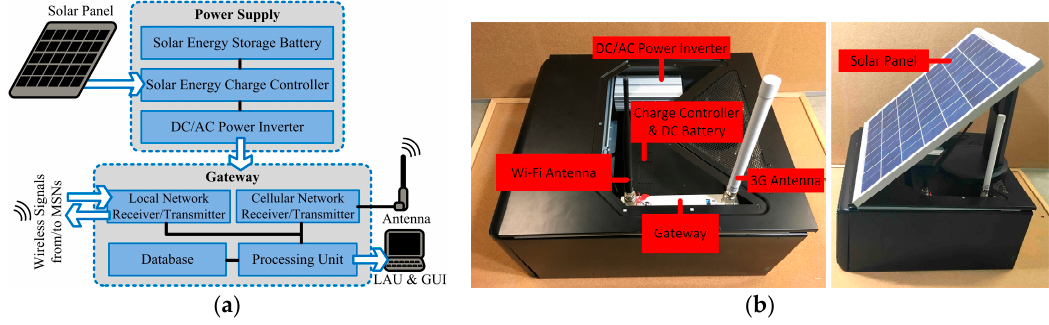
Figure 5. ( a ) The design framework of the Base Station (BS); ( b ) The developed BS in the IoT platform.